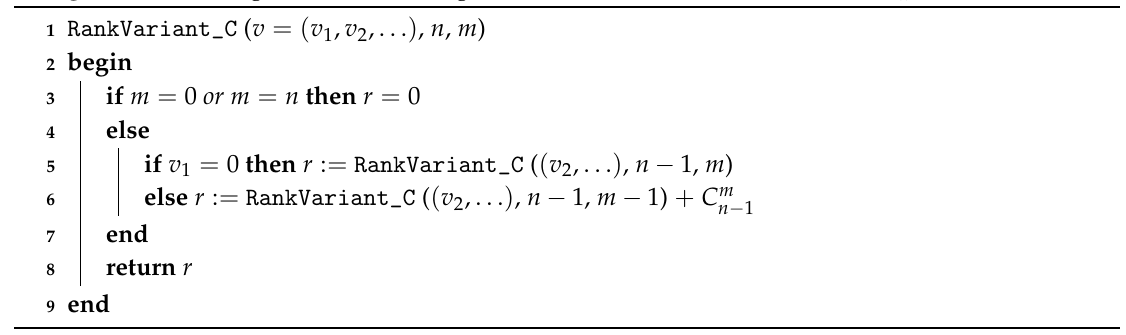
Algorithm 5: An algorithm for ranking the variants of the AND/OR tree for C m